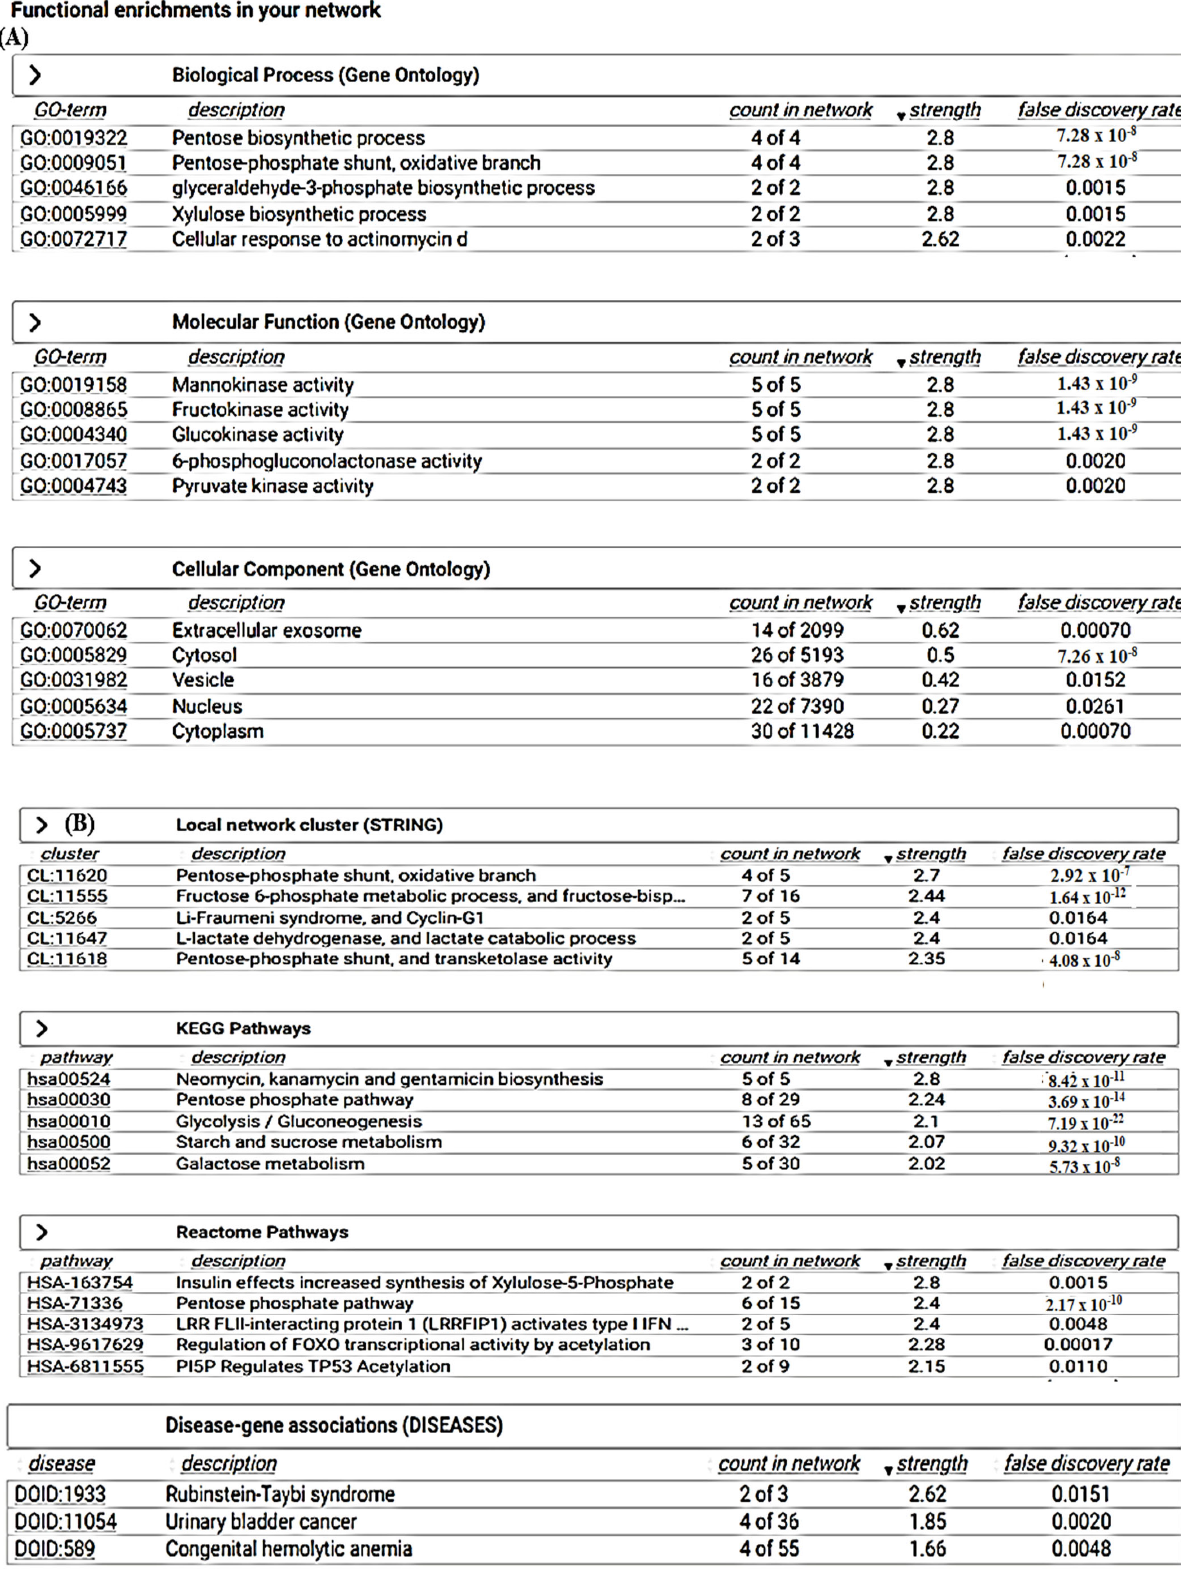
Figure 9. Functional enrichment of human G6PD protein network.